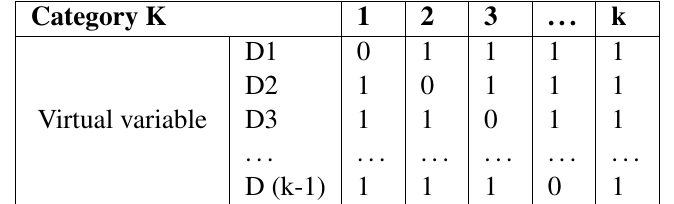
Table 1 List of dummy variable settings for college sports performance